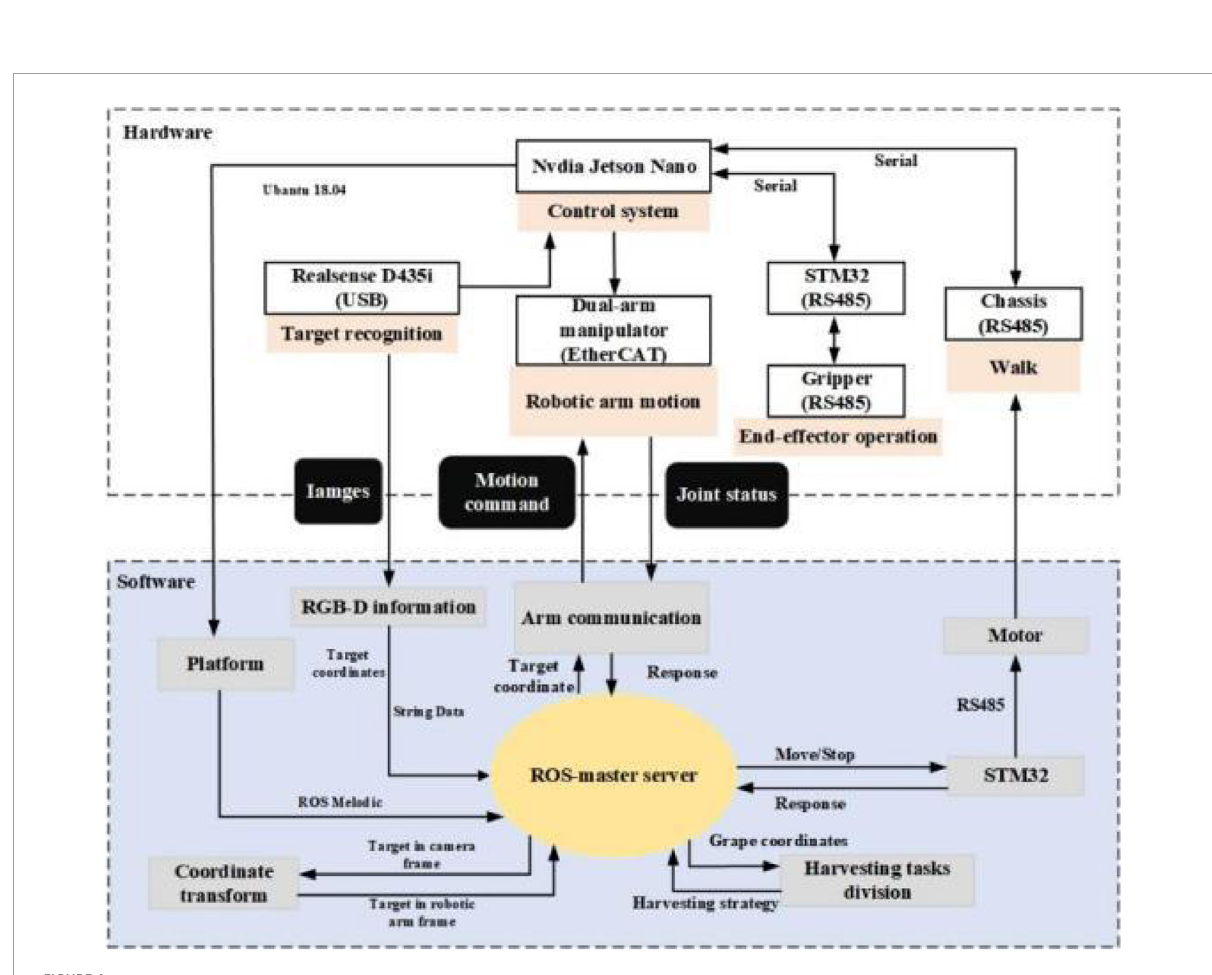
FIGURE4 Control system of the dual-arm rapid harvesting